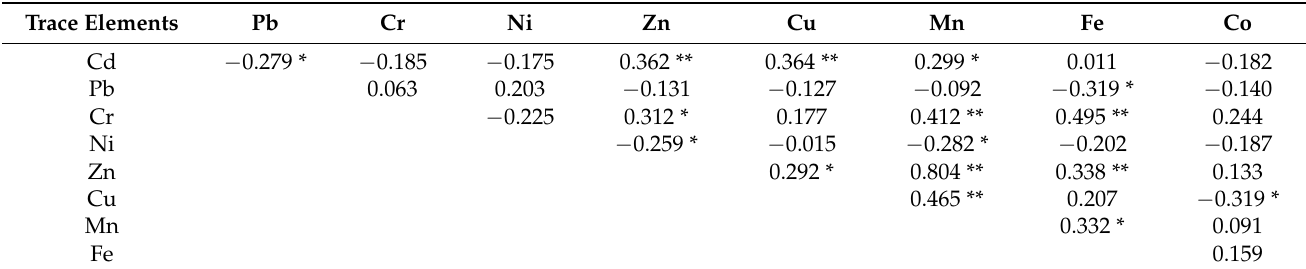
Table 4. Correlation coefficients (r) between content of trace elements in above-ground parts of maize— Zea mays L.